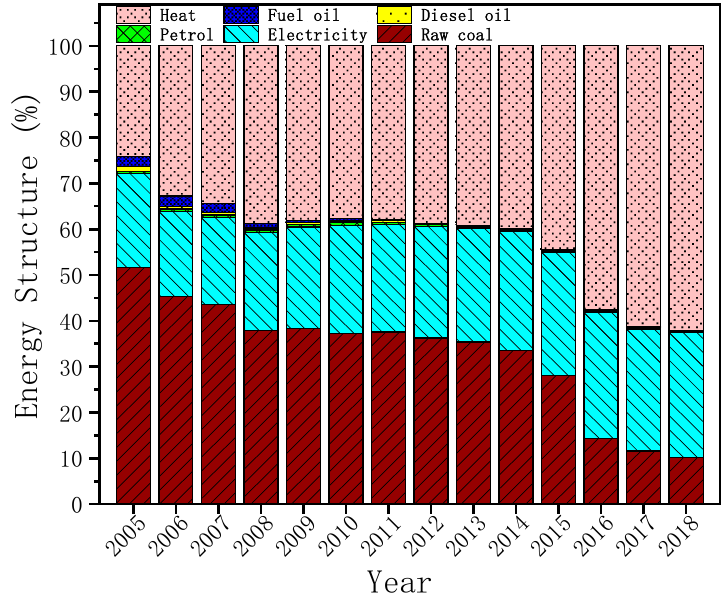
Figure 4. The energy structure of Shaoxing’s textile industry during 2005–2018.